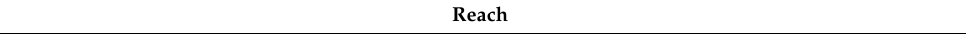
Evaluation of the IMAT Program using RE-AIM (reach, effectiveness, adoption, implementation, and maintenance)